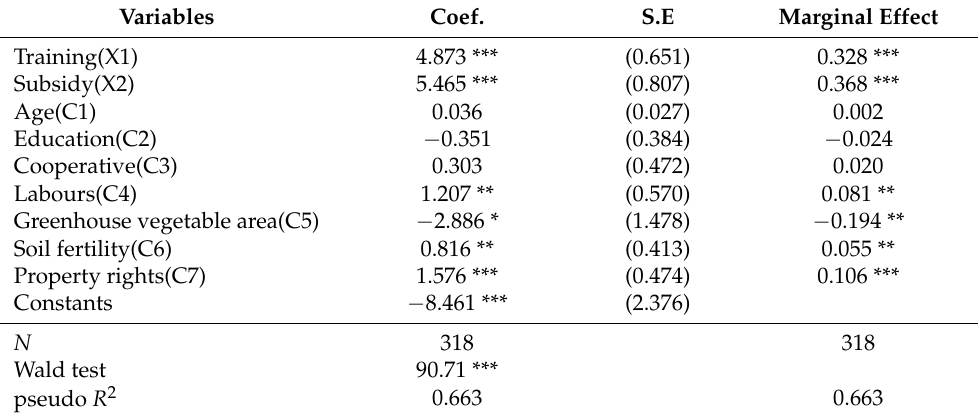
Table 2. The direct effect of program measures on farmers’ OSCF behavior.